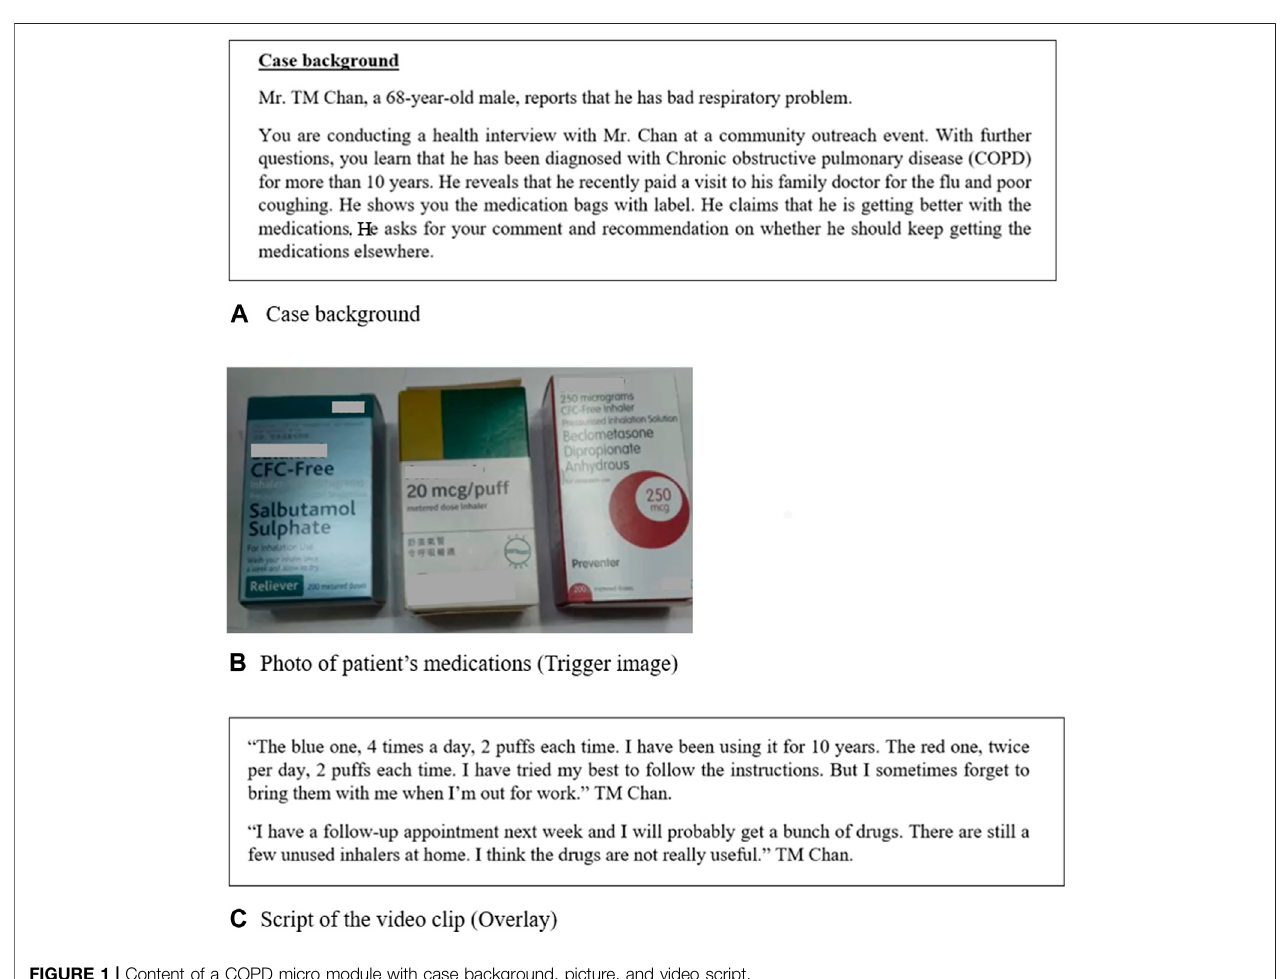
FIGURE 1 | Content of a COPD micro module with case background, picture, and video